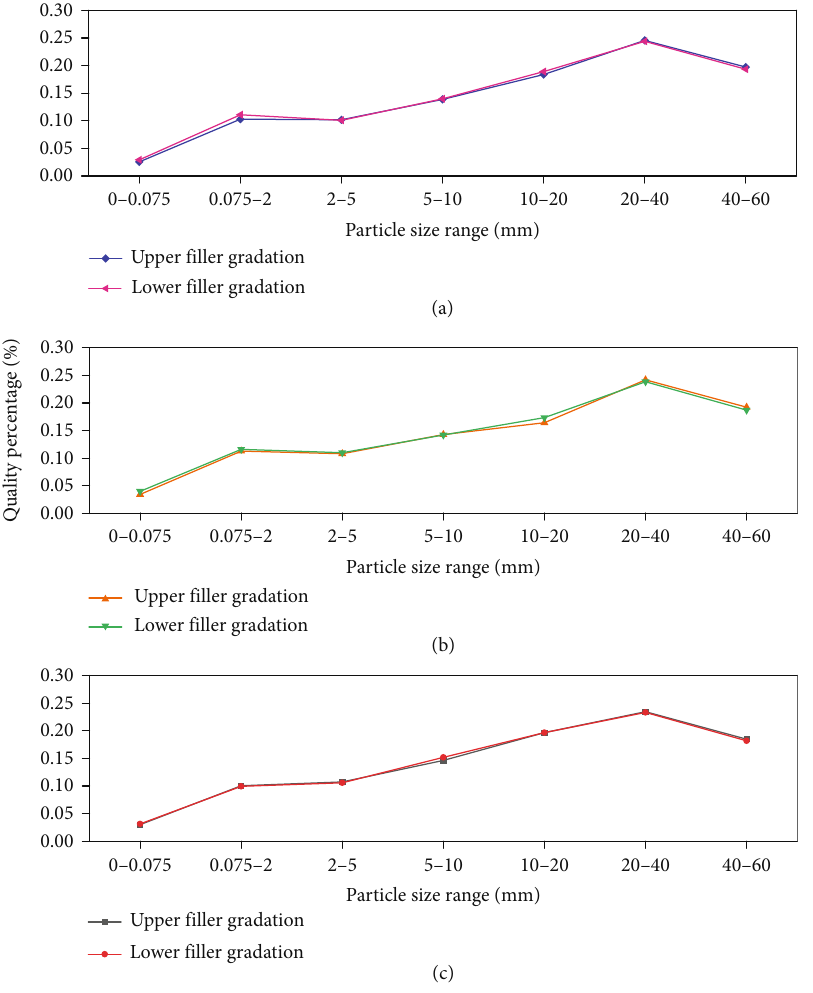
Figure 9: Comparison of particle size composition between upper and lower layers of fi ller under di ff erent rainfall conditions: (a) moderate rain condition; (b) rainstorm condition; (c) short-term heavy rainfall condition.